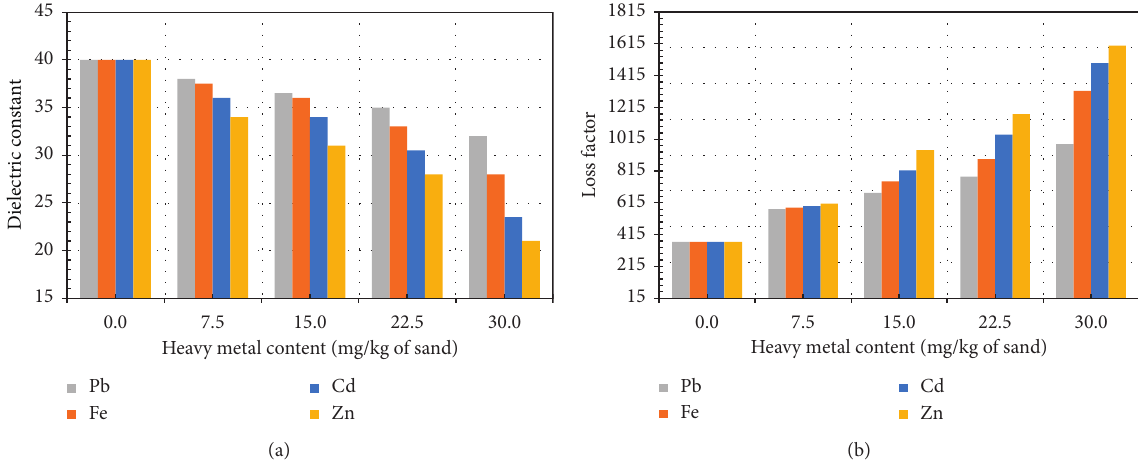
Figure 11: Effect of type and content of heavy metals on soil complex permittivity at frequency 500kHz. (a) Dielectric constant versus heavy metal content. (b) Loss factor versus heavy metal